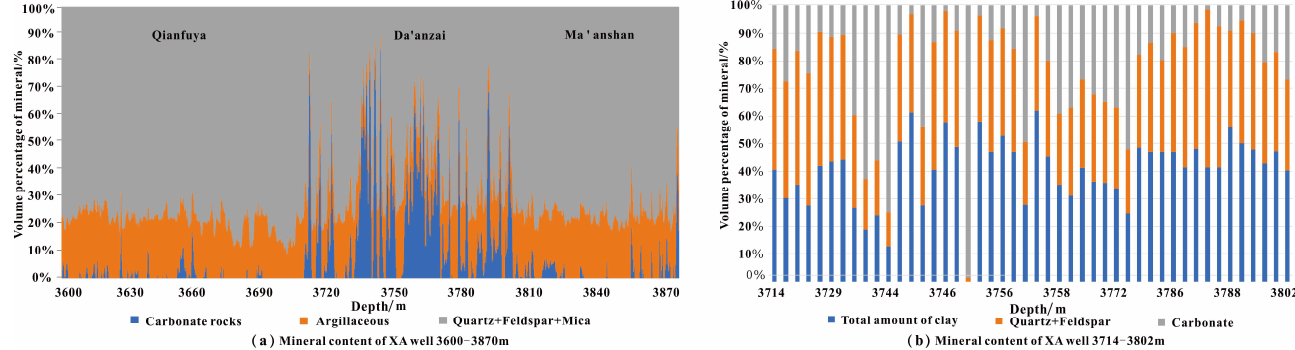
Figure 5. Mineral composition characteristics of the whole rock. ( a ) The ECS element logging data of XA well 3600–3870 m. ( b ) The whole-rock mineral X-ray diffraction analysis of XA well 3714–3802